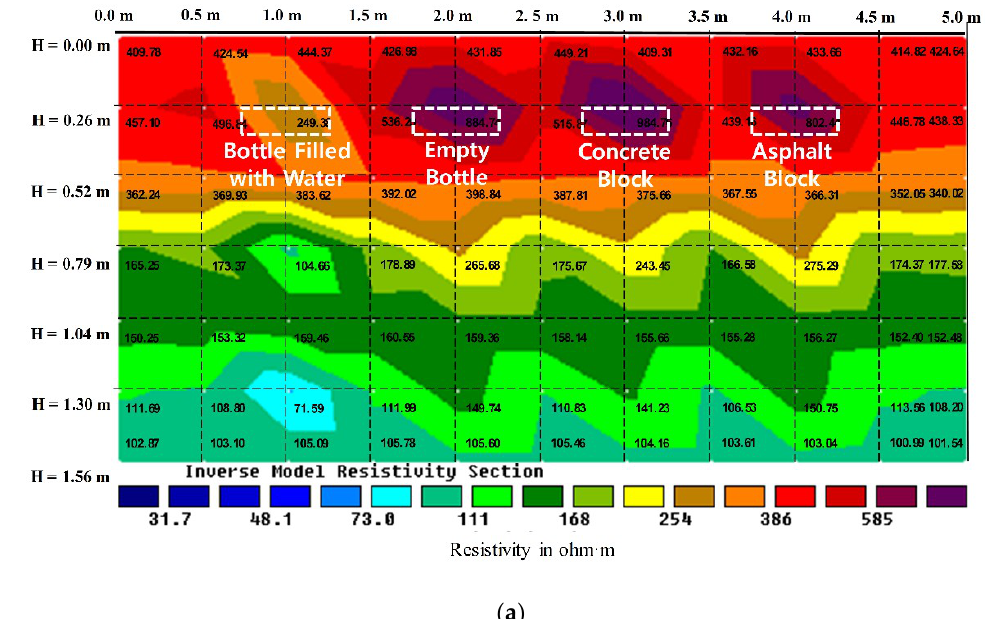
Figure 8. Test result for ground softening (Section No. 2) ( a ) Distribution of the ER. ( b ) ER according the position at each